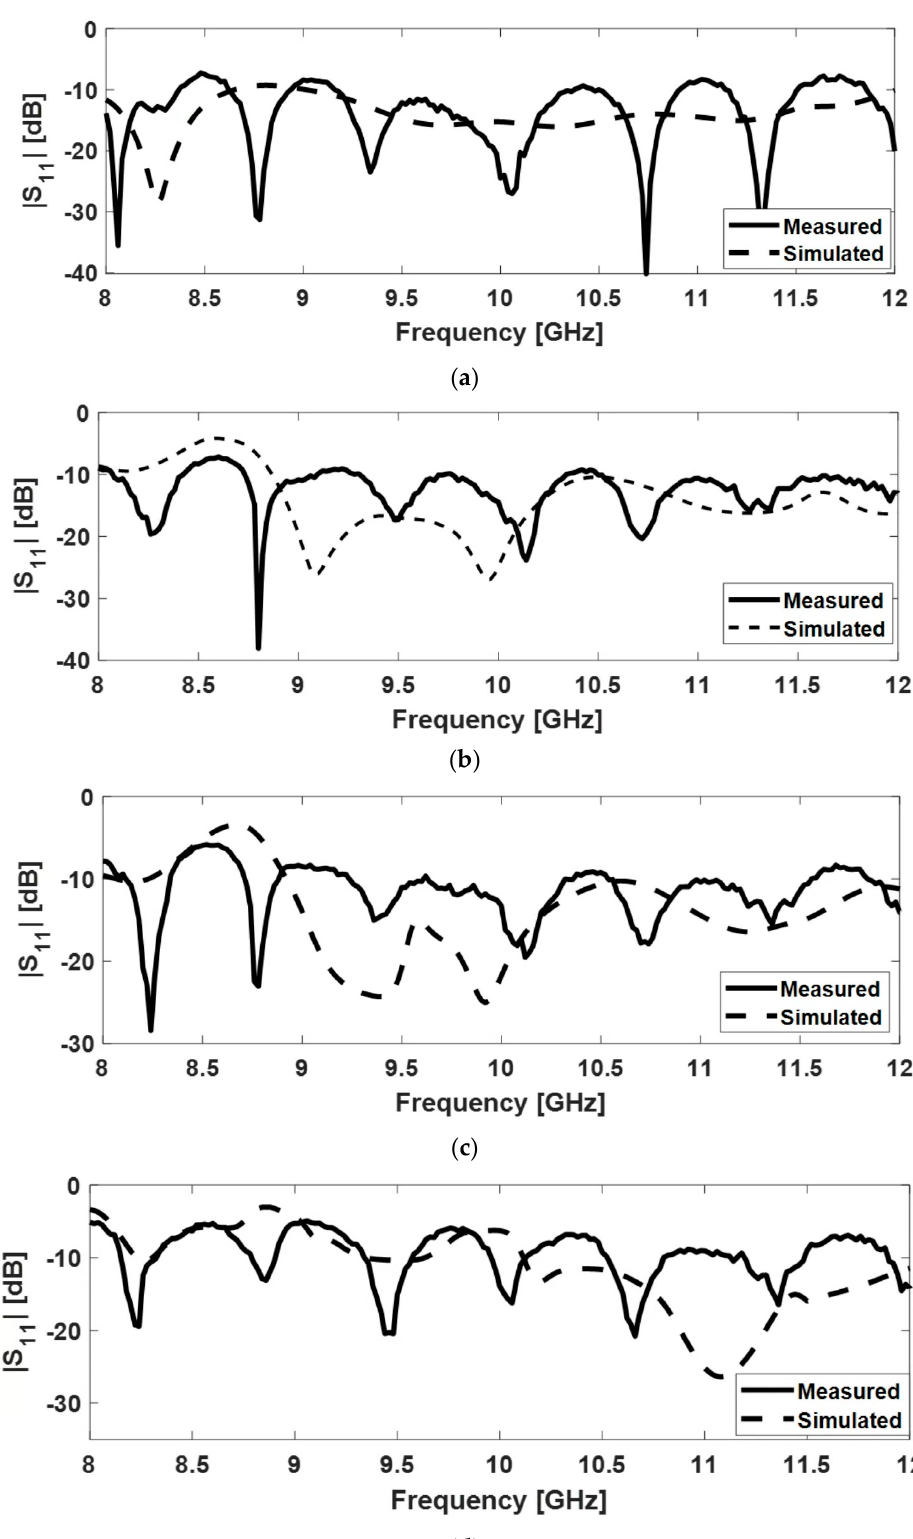
Figure 15. Magnitude of the input reflection coefficient for FSS-horn structures: versions ( a – d ).